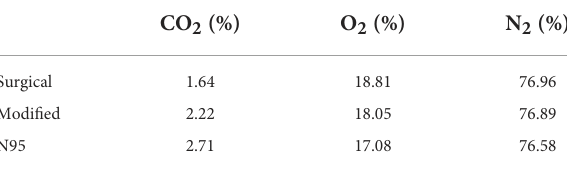
the aqueous layer; and from the inside, the mucous